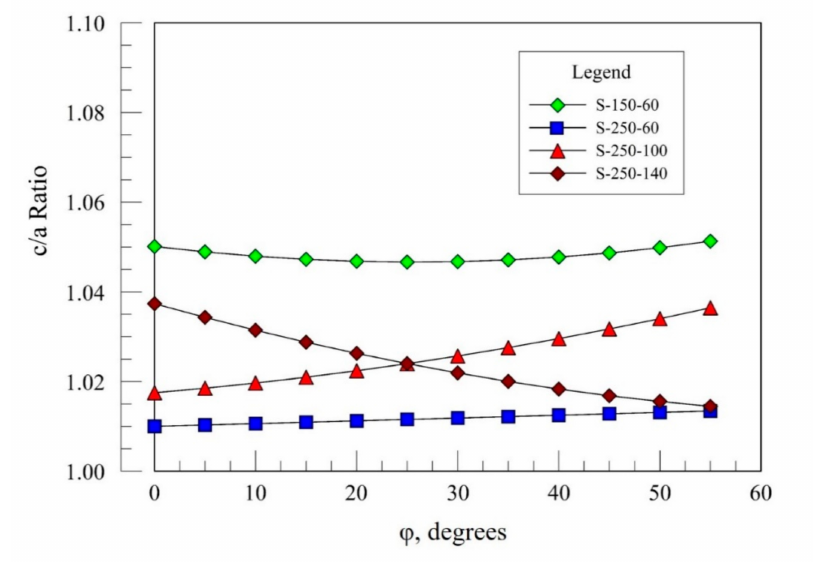
Figure 7. Calculated c / a ratio as determined from area-detector di ff raction analysis. The c / a ratios are all greater than 1.0 but the dependence on ϕ varies considerably in both magnitude and rate of change with ϕ .